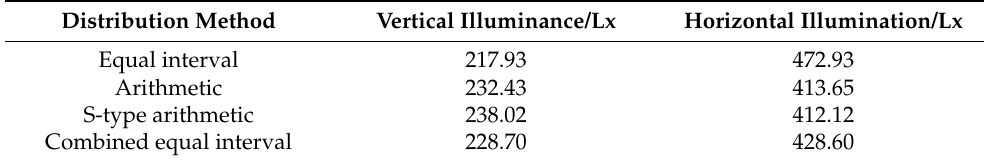
Table 2. Illuminance of LED filaments in four modes of